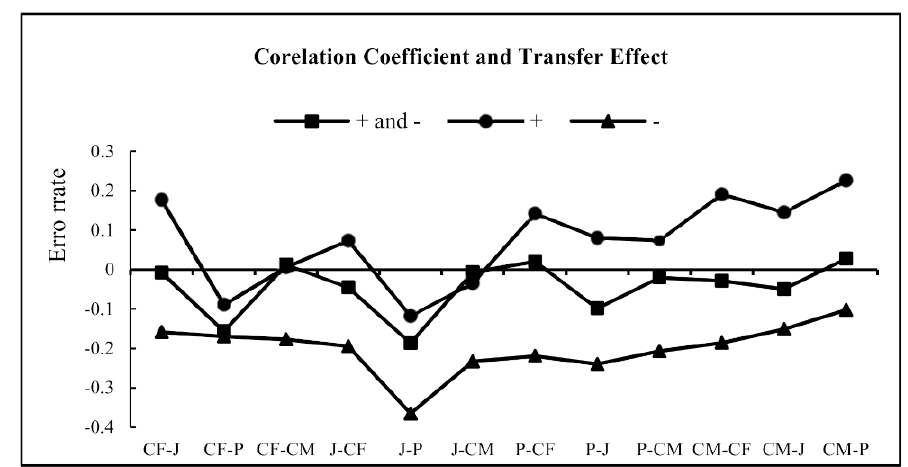
Figure 5. The error rate of correlation coefficient